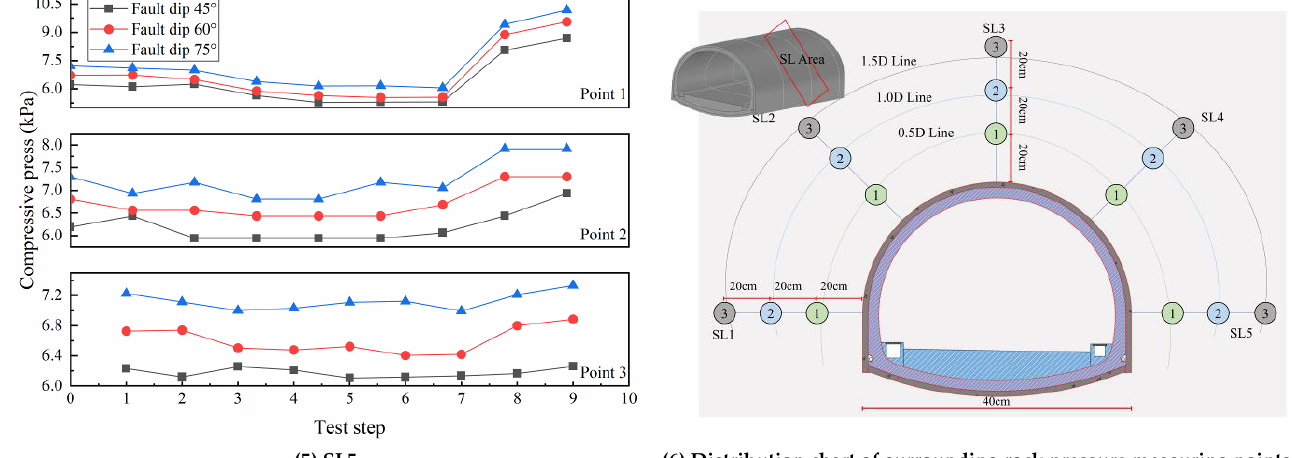
Figure 10. Line chart of rock mass pressure in the CD method.